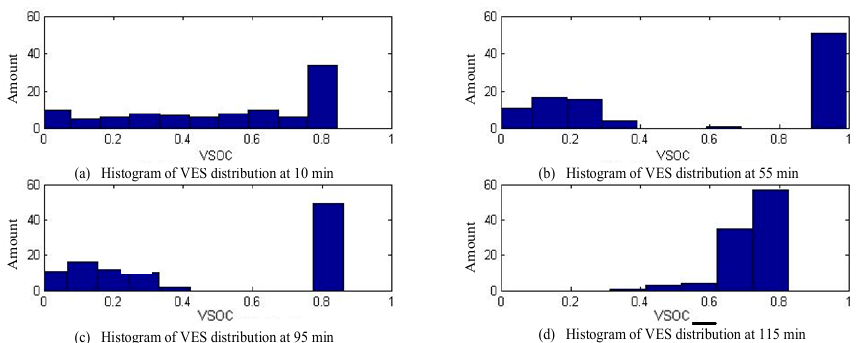
Figure 10. The variation of VES diversity.